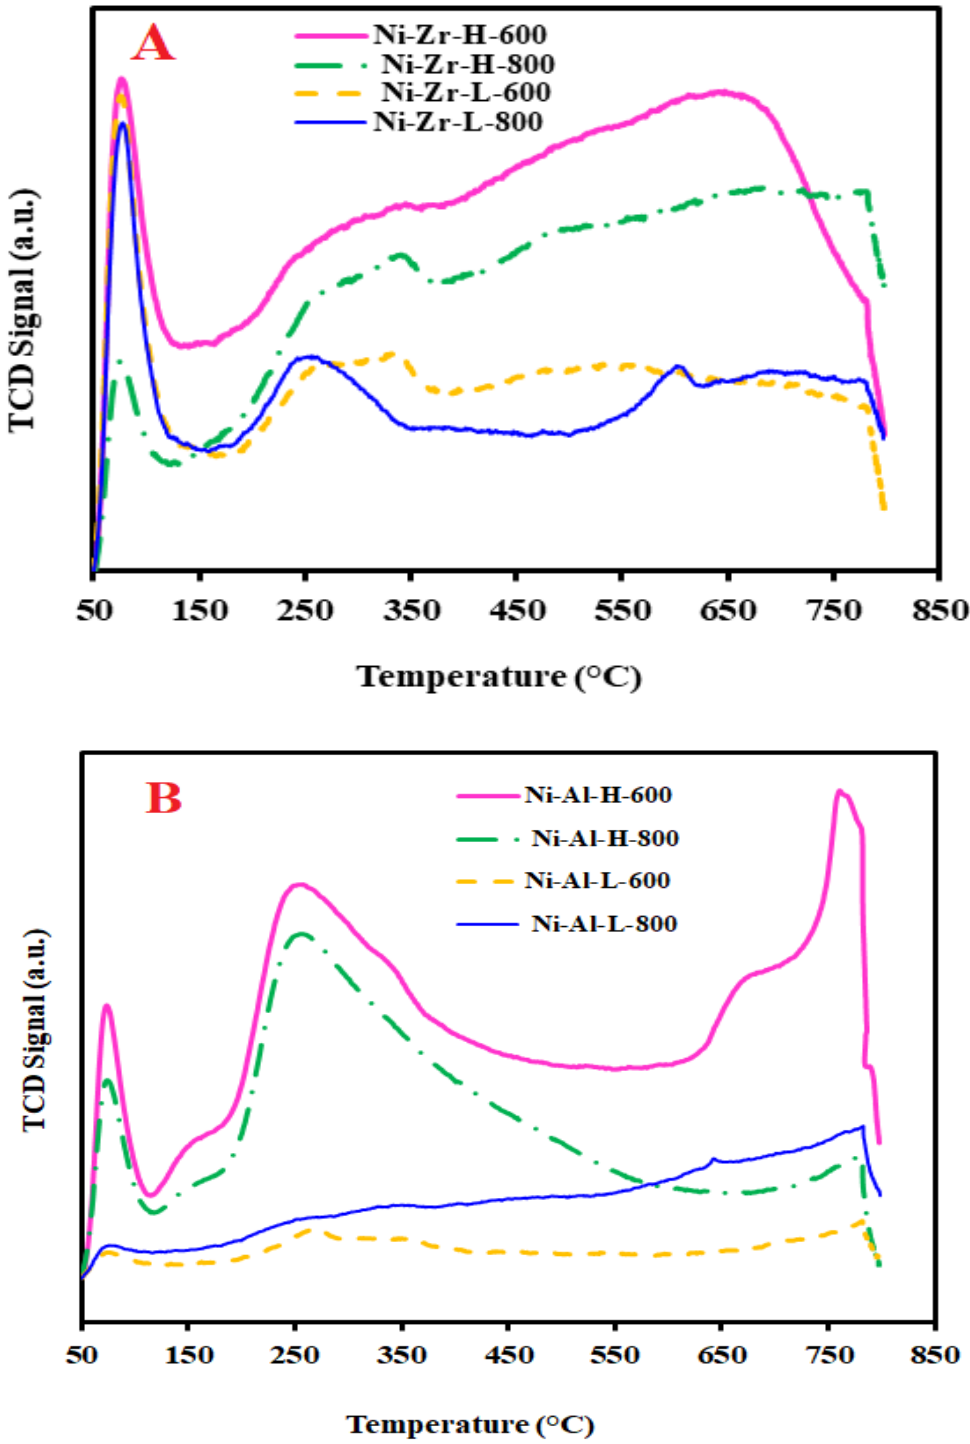
Figure 5. TPD profiles of ( A ) fresh zirconia supported- and ( B ) fresh alumina-supported catalysts ◦ calcined at 600 and 800 °C. calcined at 600 and 800